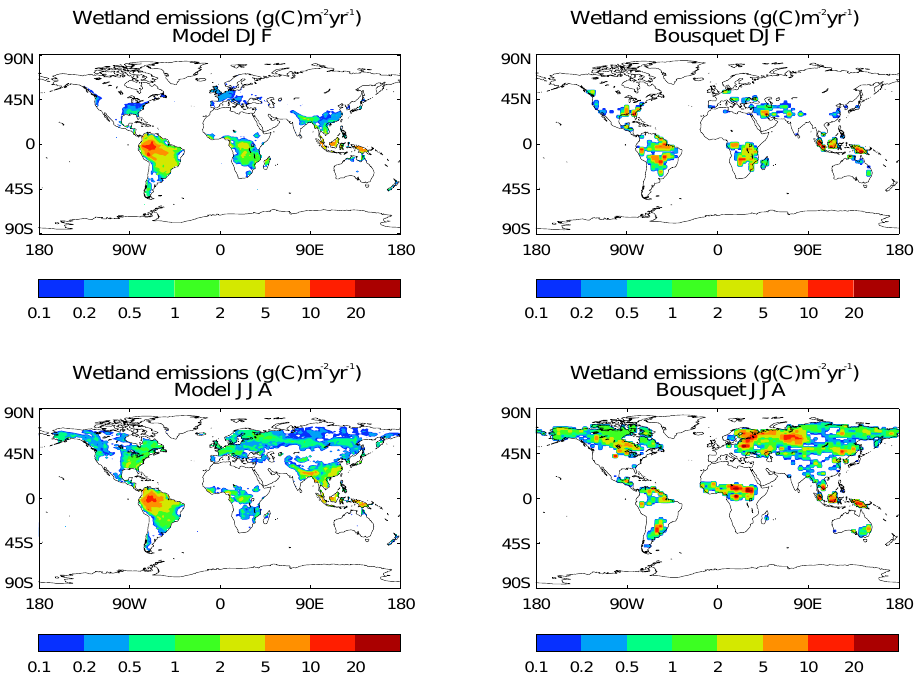
Fig. 13. Distribution of emissions of methane from wetlands provided to the HadGEM2 chemistry scheme by the large-scale hydrology, compared to those from an inversion study (Bousquet et al., 2006).